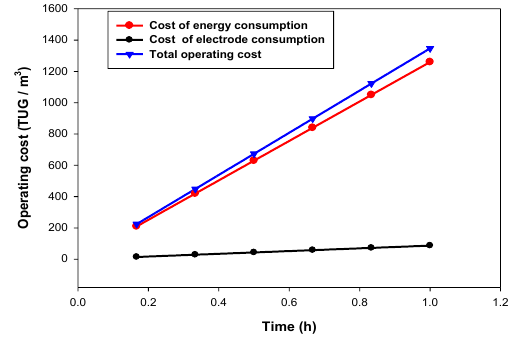
Fig. 6. Operating cost with different Variation of percentage removal of Cr 3+ with different